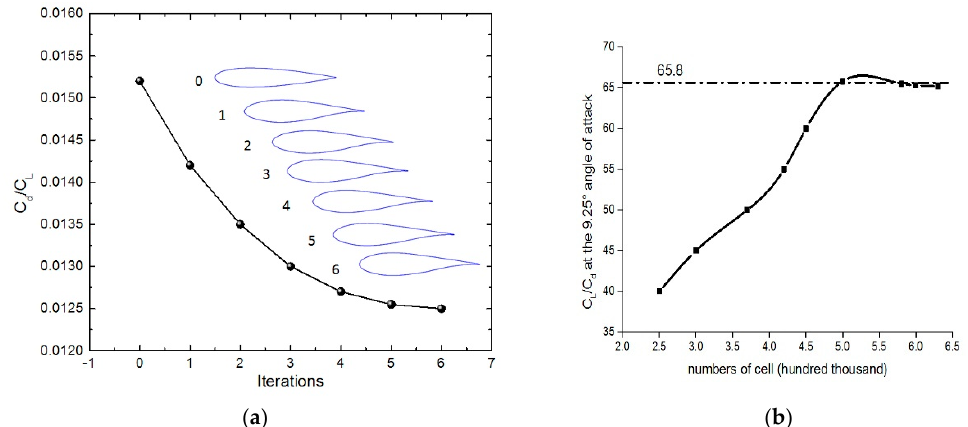
Figure 3. Airfoil optimization and convergence process. The process of the optimization was from 0 to 6, where the 0 and 6 represent the NACA 0018 airfoil and Lanzhou University of Technology (LUT) airfoil, respectively. ( a ) The constraint conditions were the minimum C d /C L , thickness, and camber of the airfoil for the LUT airfoil. ( b ) The maximum lift–drag ratio of the NACA 0018 is 65.8 at an angle of attack of 9.25° [28]. In this Figure, the R e is 5 × 10 5 .